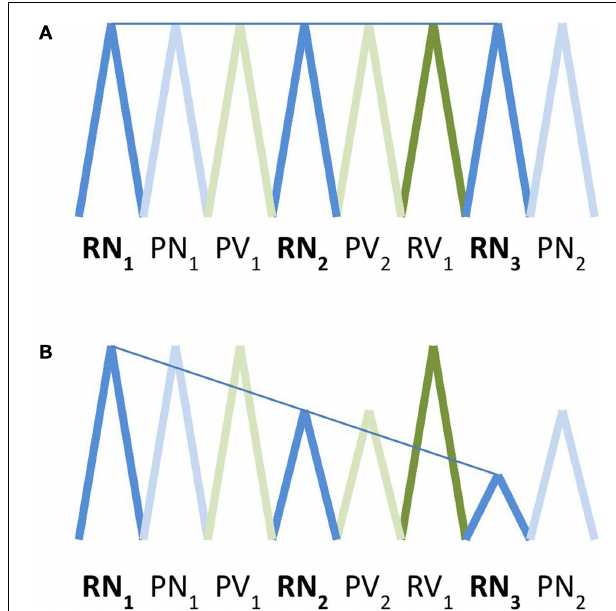
FIGURE 1 | Schematic depiction of basis functions used for modeling of activation (A) and adaptation (B). Square wave functions convolved with the standardized hemodynamic response function are represented here as triangle waves for ease of illustration. In the activation model, the amplitude of activation within a voxel for a given trial type was expected to remain constant over time. In the activation model, the amplitude of activation for a given trial type was expected to decrease in a linear fashion over successive trials. RN, real noun; RV, real verb; PN, pseudonoun; PV,